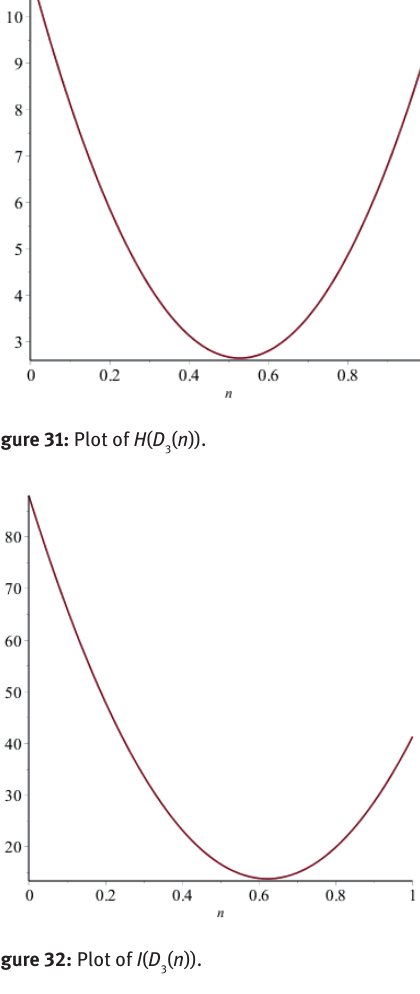
Figure 32: Plot of I ( D